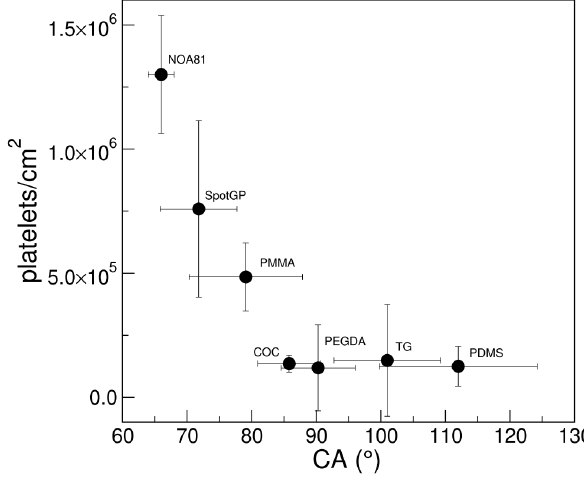
Figure 3. Correlation between platelet adhesions measured with SEM (density as platelets/cm 2 ) and wettability (CA) of polymeric materials.